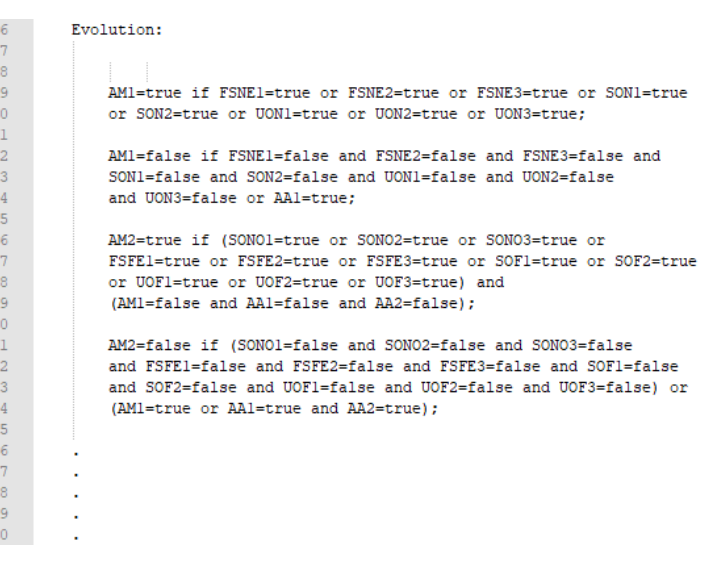
Figure 9. Schematic for the worst case analysis of the evolution rules in Figure 10. The black arrows illustrate approaching E with its sensing and decision paths extended on both sides of the 3 m and 6 m zones ahead and on the side of the AV (rectangular box).